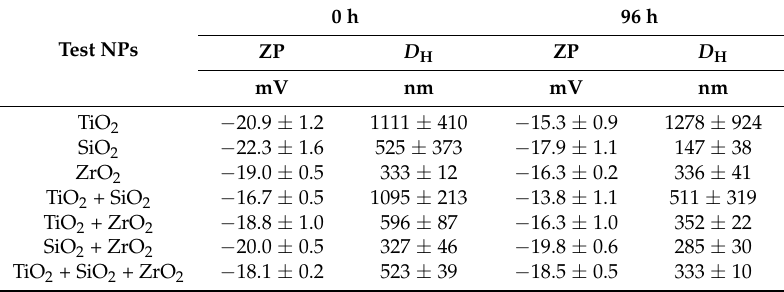
Figure 1. SEM images of the pristine NPs and TEM images of the NPs from single to ternary mixture systems in the algae medium. Table 1. Zeta potential (ZP) and hydrodynamic diameter ( D H ) ± standard deviation of the test NPs from single to ternary mixture systems.